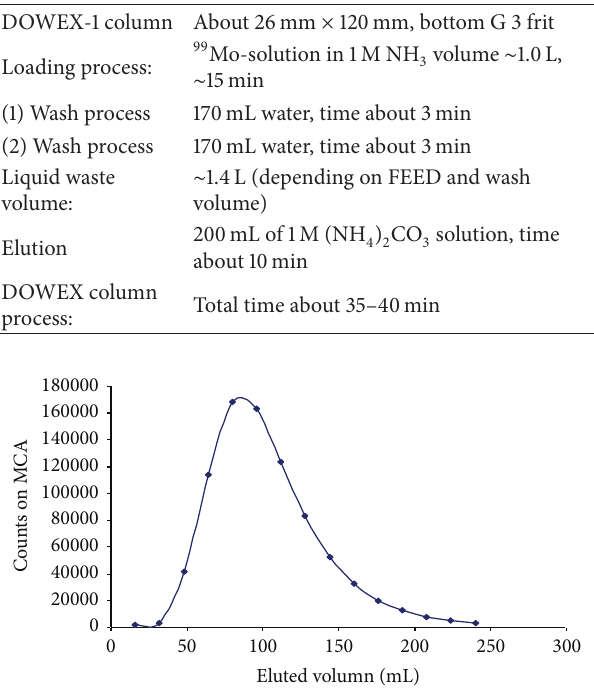
Table 3: Optimal parameters for the DOWEX-1 column process.